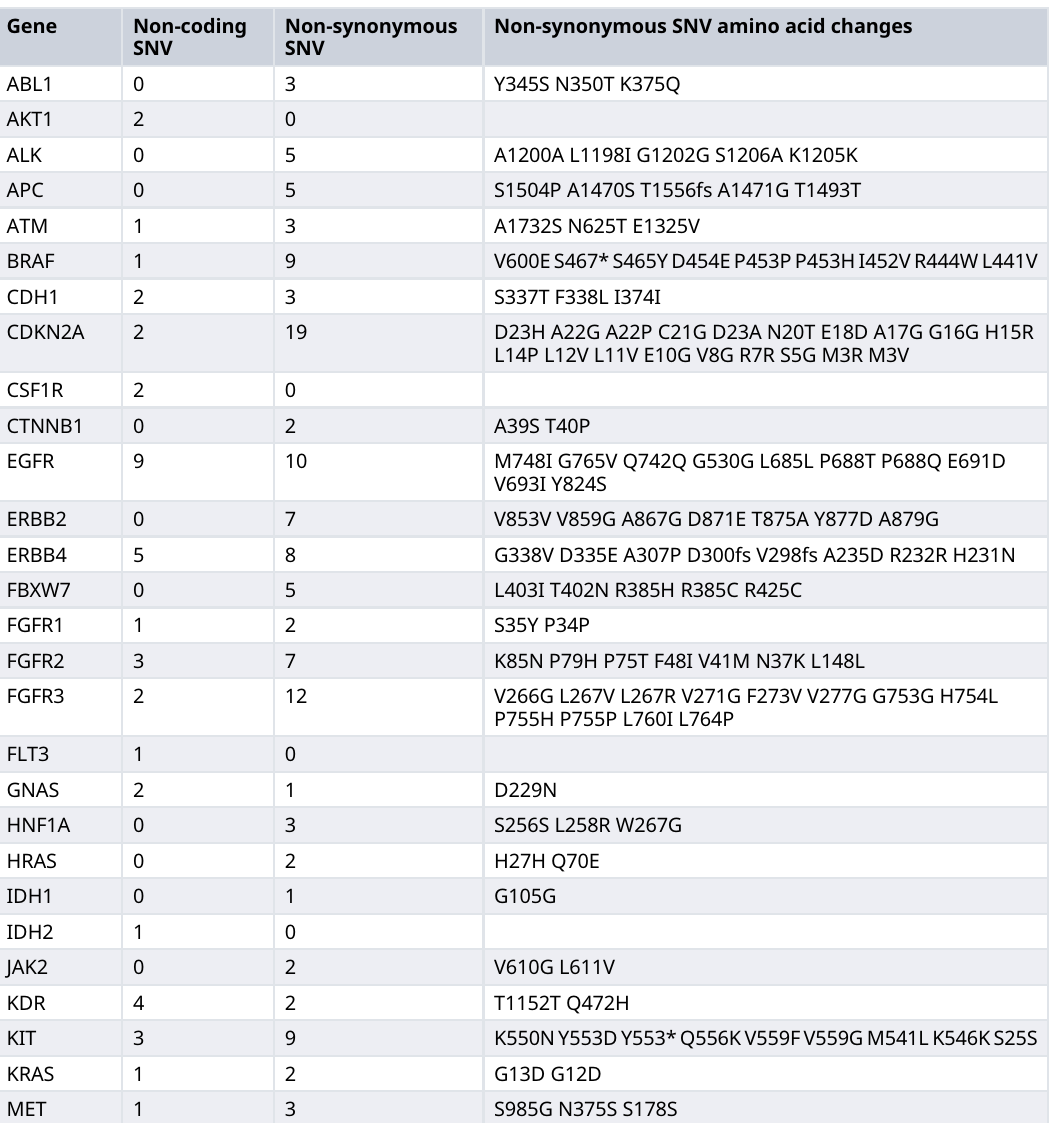
Table 2. List of SNVs observed in at least 90% of samples with depth >